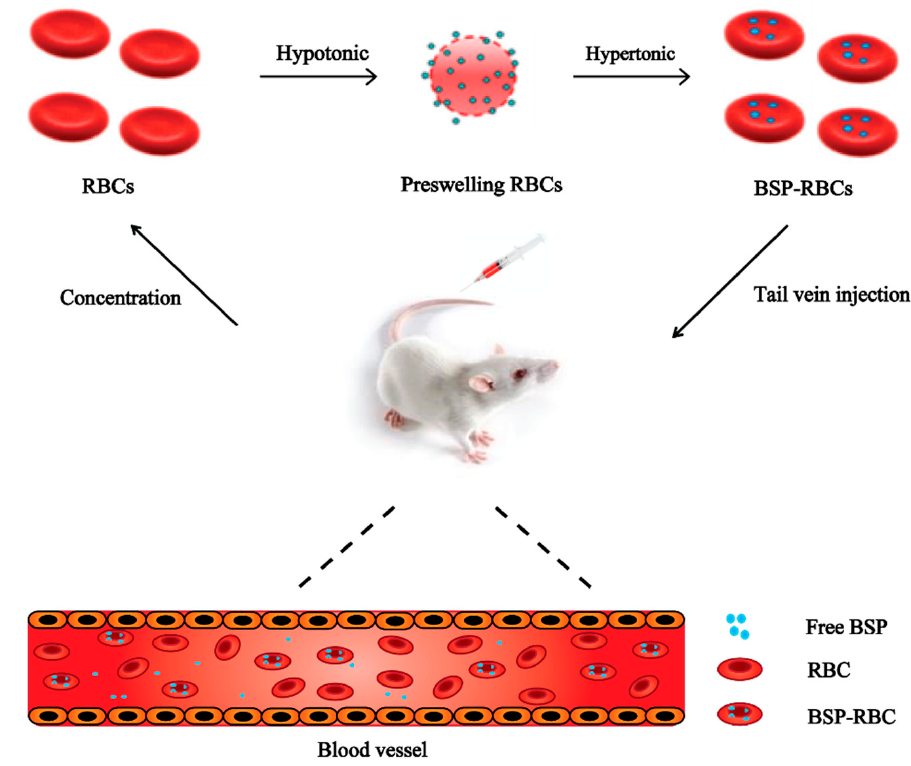
Figure 1. Drug loading scheme.